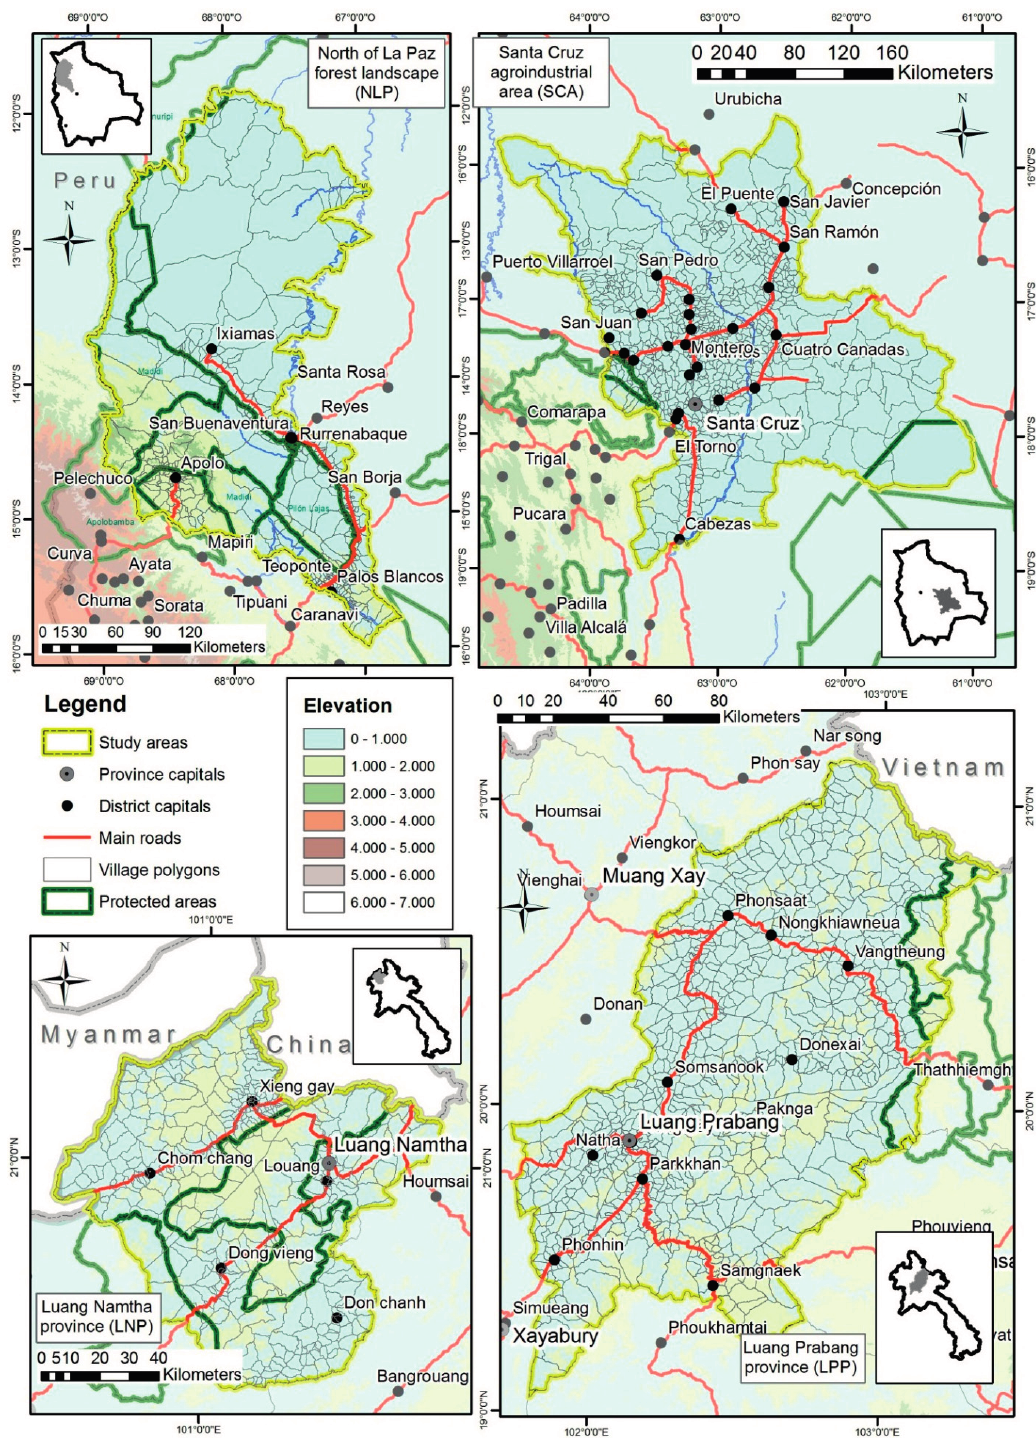
Figure 1. Overview of the four study